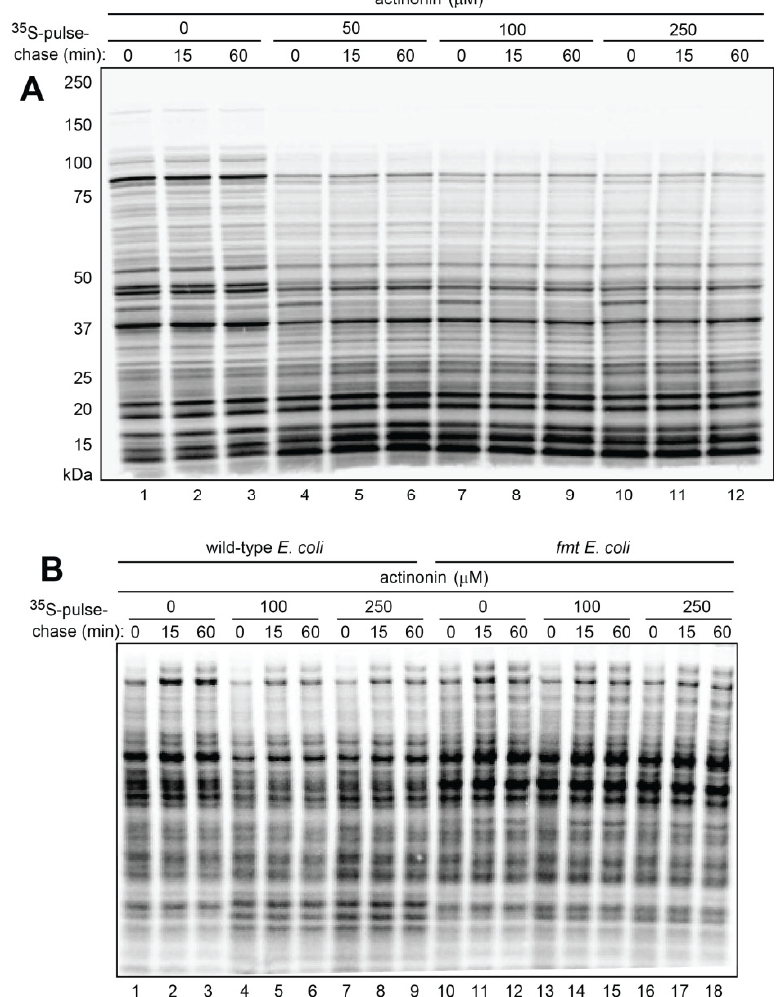
FIGURE 2: Pulse-chase analyses in wild-type and formylation-lacking fmt E. coli in the ab- sence or presence of actinonin, an inhibitor of deformylation. (A) Wild-type E. coli were pulse-labeled with 35 S-methionine/cysteine for 1 min, followed by a chase (in the presence of chloramphenicol, a translation inhibitor) for indicated times, extraction of proteins, SDS- PAGE, and autoradiography. Pulse-chases were carried out either in the absence of actinonin (lanes 1-3) or in the presence of increasing concentrations of actinonin (lanes 4-12). Mo- lecular masses of protein markers are indicat- ed on the left. (B) Same as in (A) but pulse-chases were carried out in the absence of chloramphenicol in wild-type cells (lanes 1- 9) and congenic fmt E. coli (lanes